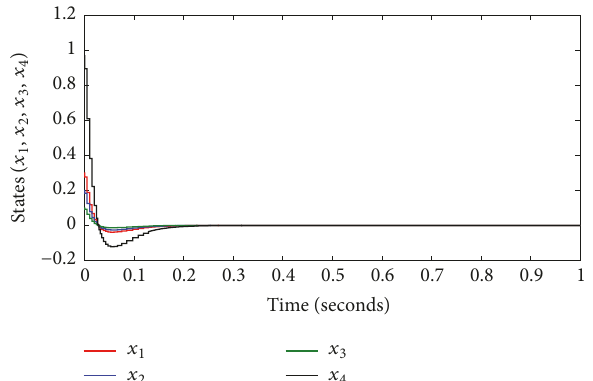
Figure 19: Time history of FOSG states controlled with FPGA implemented GAFOPID controllers.